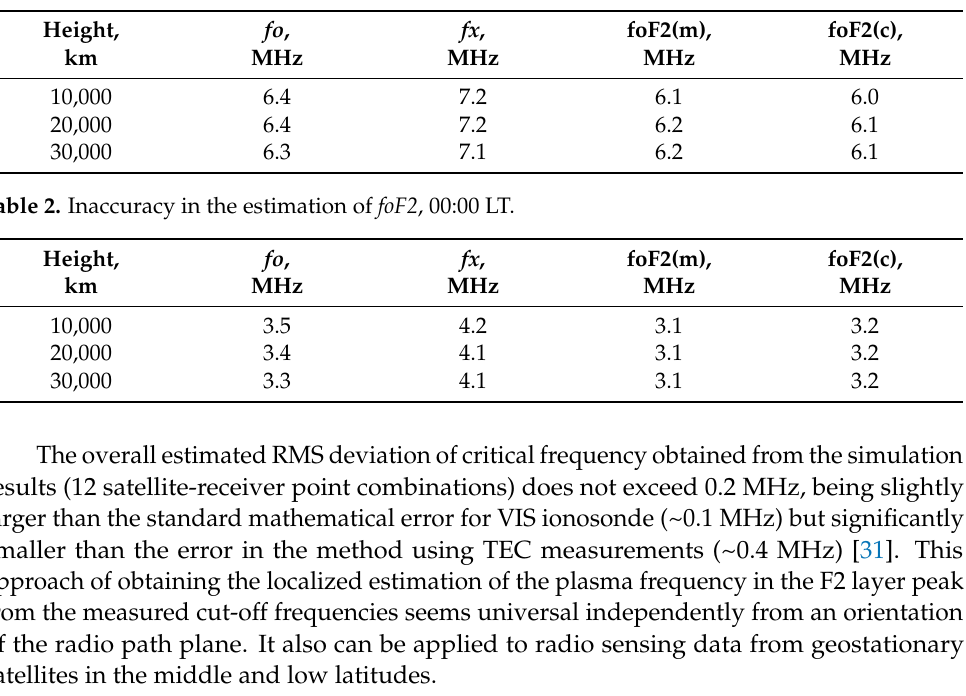
Table 1. Inaccuracy in the estimation of foF2 , 12:00 LT.